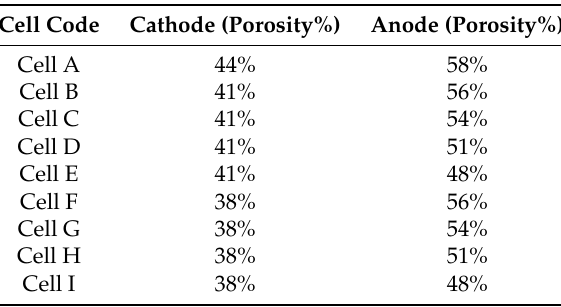
Table 1. Cell index with anode and cathode